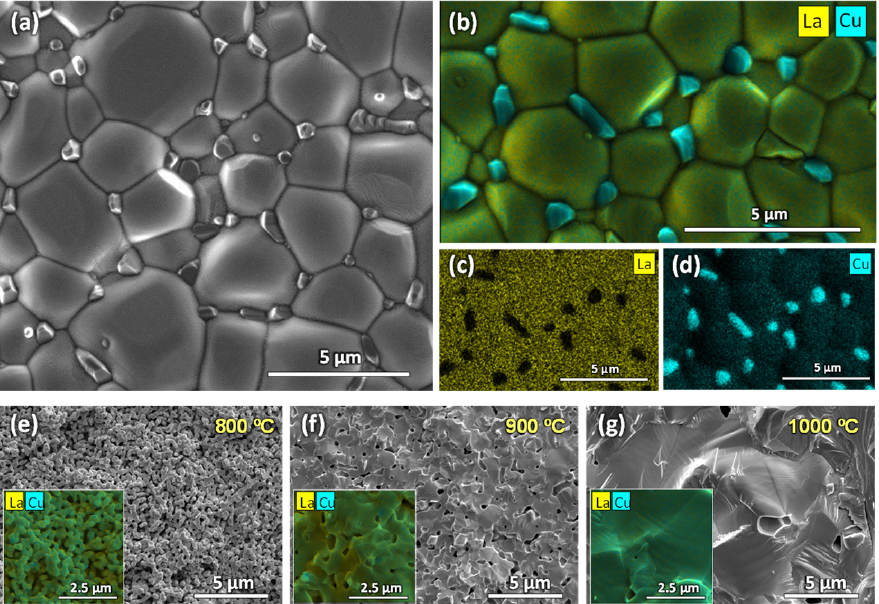
Figure 4. ( a ) Surface SEM image and the corresponding ( b – d ) EDS of LCO sintered at 1000 ◦ C for 1 h. Cross-sectional SEM images and EDS of La 2 CuO 4 − δ pellets sintered at ( e ) 800, ( f ) 900 and ( g ) 1000 ◦ C for 1 h.